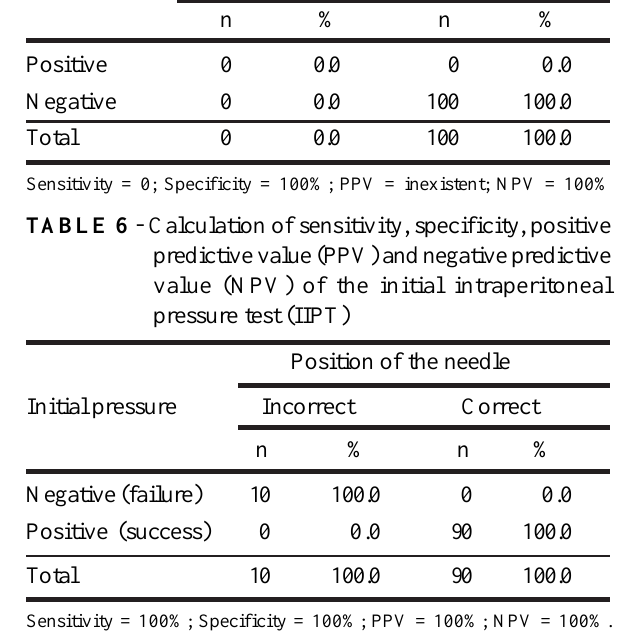
FIGURE 4 - Proportion of failed attempts to reach the peritoneal cavity for each test, with their respective confidence